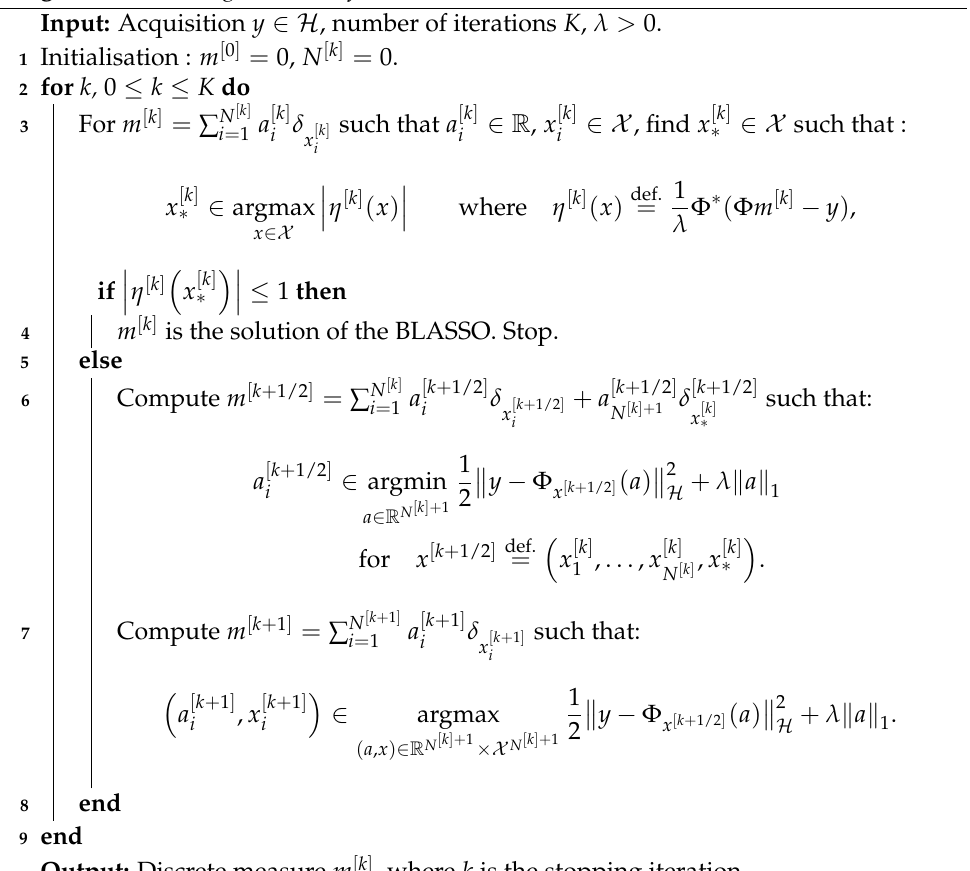
Algorithm 3: Sliding Frank-Wolfe